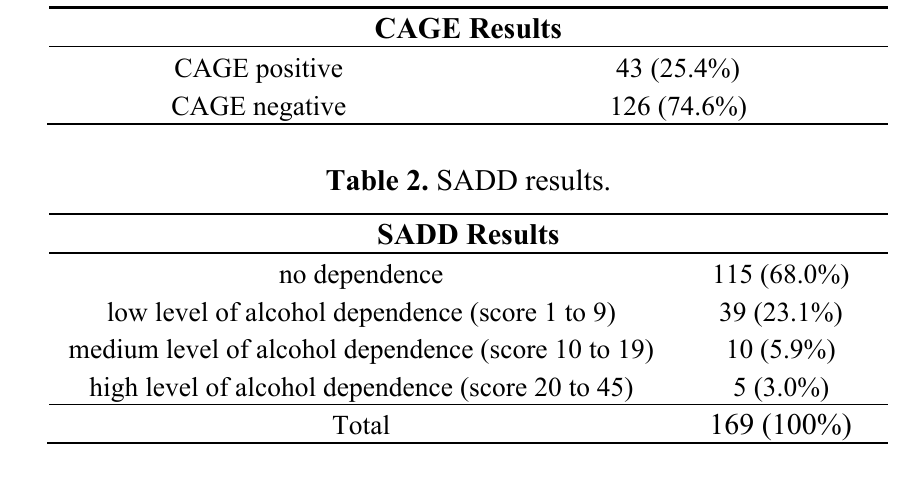
Table 3. Comparison between alcohol dependents and non-dependent